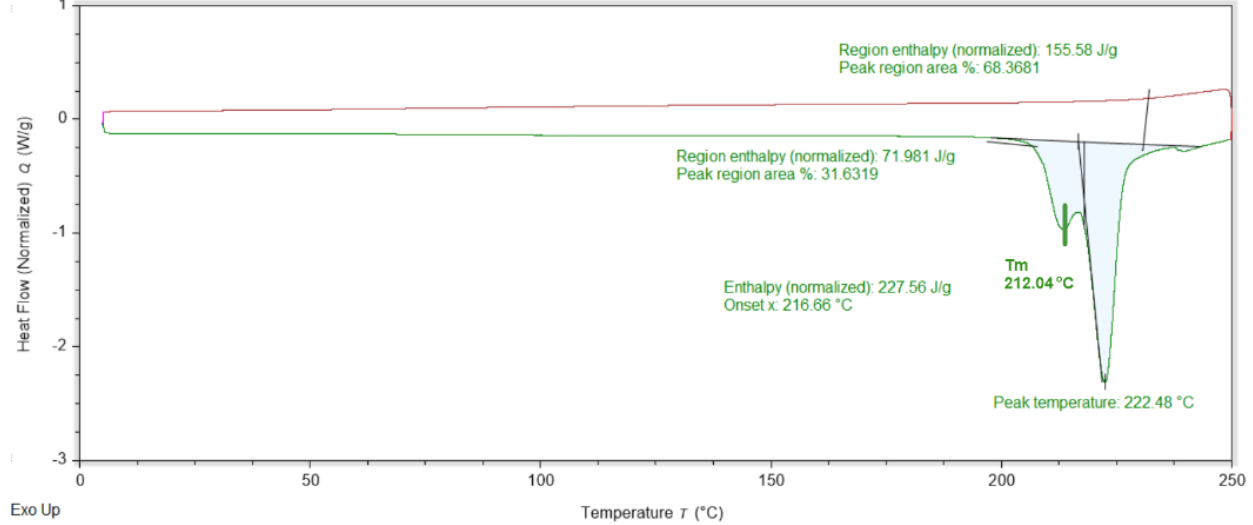
Figure 3. Graphical representation of the results from the DSC analyses for amantadine.HCl. The maximum of the endothermic peak, corresponding to the melting temperature (Tm) is denoted followed by the decomposition peak. The red line corresponds to the cooling stage from 250 to 0 °C.